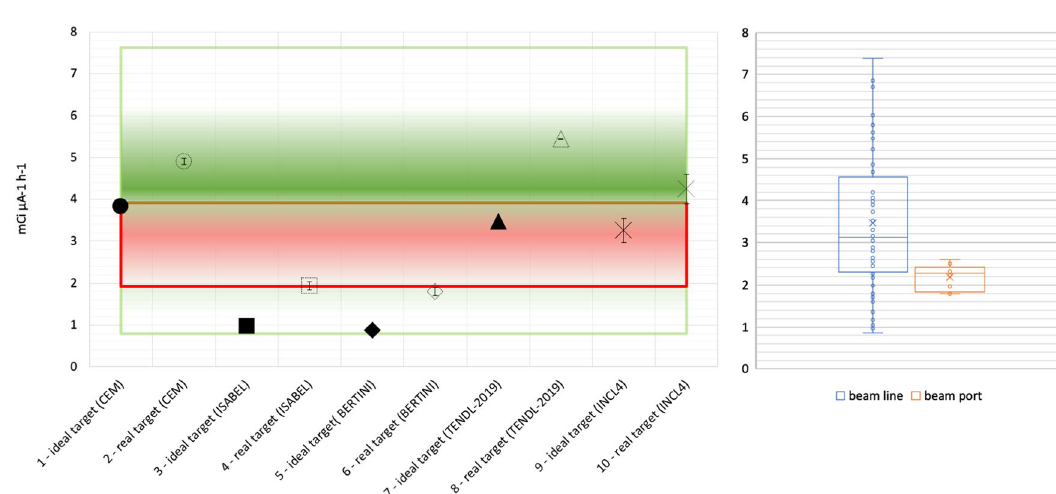
Figure 7. Left, 64 Cu yield estimated with cross sections and model physics for ideal and real targets. Red band indicates the values experimentally found by COMECER with the ALCEO system mounted on cyclotron beam ports (the higher the color intensity, the higher the frequency of the experimentally found activity; color band centered on the 2.5 value). The green band instead is referred to a PTS device directly interfaced with the beam line. Right, experimental data obtained by COMECER. Chart showing results for beam line (blue) and beam port (orange) together with experimental values (dots), mean (cross), local minimum and maximum (horizontal rays) and the rectangle showing median and 25th-75th percentiles as in the usual “Box and Whisker” representation. Y axis, mCi μA −1 h −1